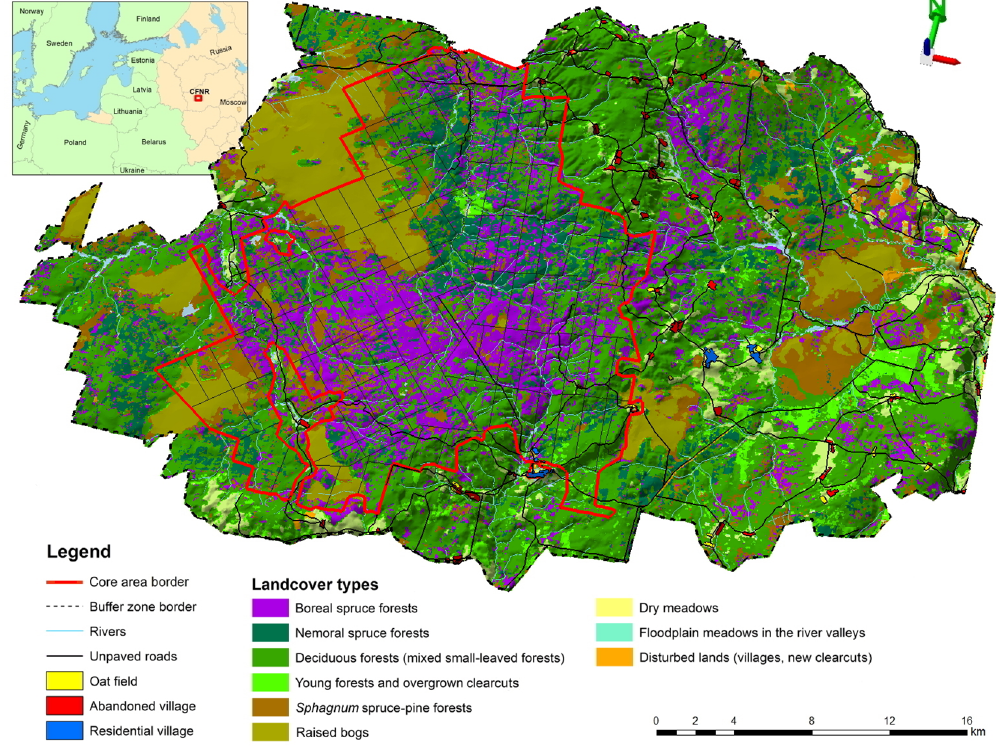
Figure 1. Map of the Central Forest State Nature Reserve (CFNR) core area (red line) and buffer zone (black, dotted line) in West-European Russia. The classification of landcover types, based on the interpretation of Landsat 8 satellite images, was superimposed on a three-dimensional digital elevation model obtained from NASA’s Shuttle Radar Topography Mission (SRTM) at a resolution of 30 m. For better visualisation of the elevation difference, z-scaling was used (z-factor = 15). The CFNR forest flora is mainly composed of boreal species widespread in the taiga zone with a dominance of Picea abies L. (hereinafter—spruce) and nemoral species such as Tilia cordata Mill., Corylus avellana L., Ulmus glabra Huds., and U. laevis Pall. Populus tremula L., Betula spp., Alnus incana L., and A. glutinosa L. usually predominate in the disturbed areas after windfalls or forest logging. A special place belongs to Sphagnum -dominated raised bogs and Sphagnum forests with Pinus sylvestris . The CFNR fauna is of European origin, but it includes striking Siberian representatives, the European distributions of which are usually related to boreal landscapes [38]. The common species among large carnivores are brown bear, gray wolf Canis lupus L. , and Eurasian lynx Lynx lynx L. Among ungulates, there is a high density of moose Alces alces L. and moderate densities of roe deer Capreolus capreolus L. and wild boar Sus scrofa L. 2.2. Food-Probability Models All key steps for model building are presented according to the general recommendations for SDM studies [4,12]. The model objectives were aimed at studying the relationships between brown bear food resources and their environment (explanation), and mapping their spatial distribution. We describe our models following the Overview, Data, Model, Assessment, Prediction (ODMAP) protocol (ver. 1.0) for SDM [4] with the use of the range model metadata standards (RMMS) dictionary [39]. Here, we provide an overview and the main settings of the distribution models while the remaining ODMAP sections and data processing are detailed in Table S1. The general view of the modelling workflow with the seven main steps is shown in Figure 2. All data processing, analysis, and modelling were done using RStudio 1.1.447 software based on R 4.0.3 [40].